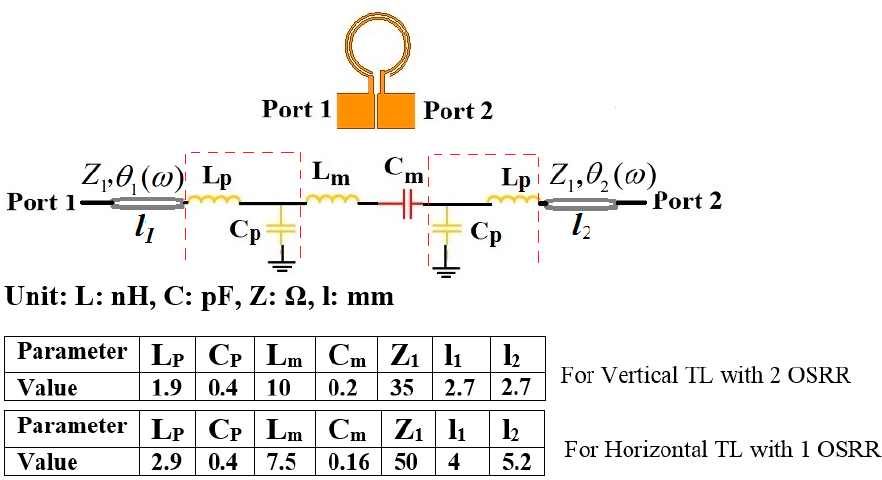
Figure 3. Circuit model (unit cell) of proposed artificial TLs based on OSRR with obtained elements value for vertical and horizontal sections.